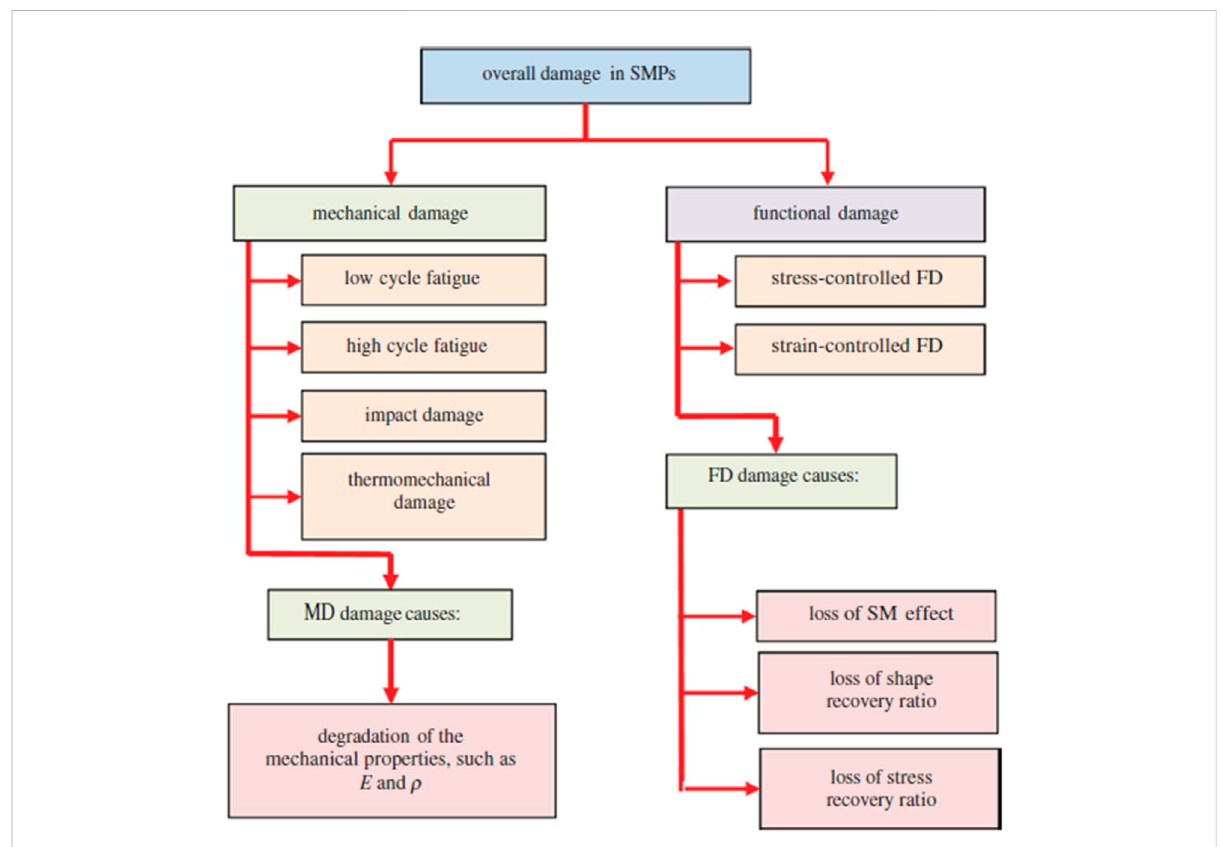
FIGURE 12 Flowchart for the damage categories in an SMP system (Shojaei and Li, 2014). [Reproduced with permission from Proceedings of the Royal Society A, 470: 20140199., (2014). Copyright 2014 Royal Society].